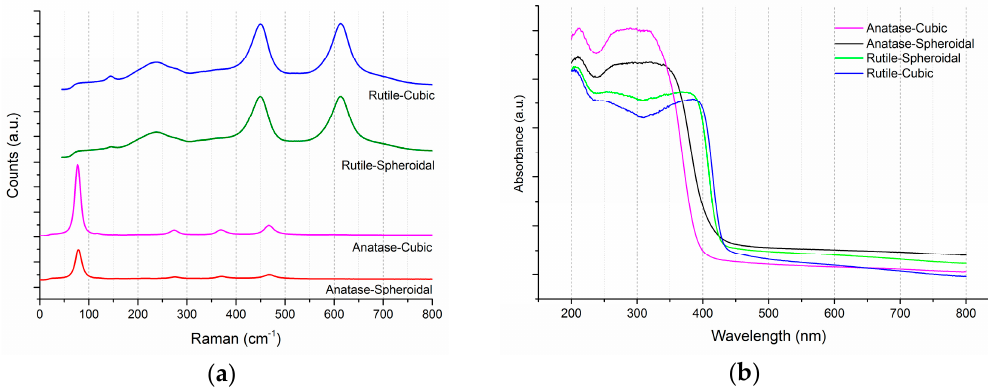
Figure 2. Raman and UV-VIS spectra of anatase and rutile TiO 2 in both ( a ) cubic, and ( b ) spheroidal shapes. a.u.: arbitrary unit.